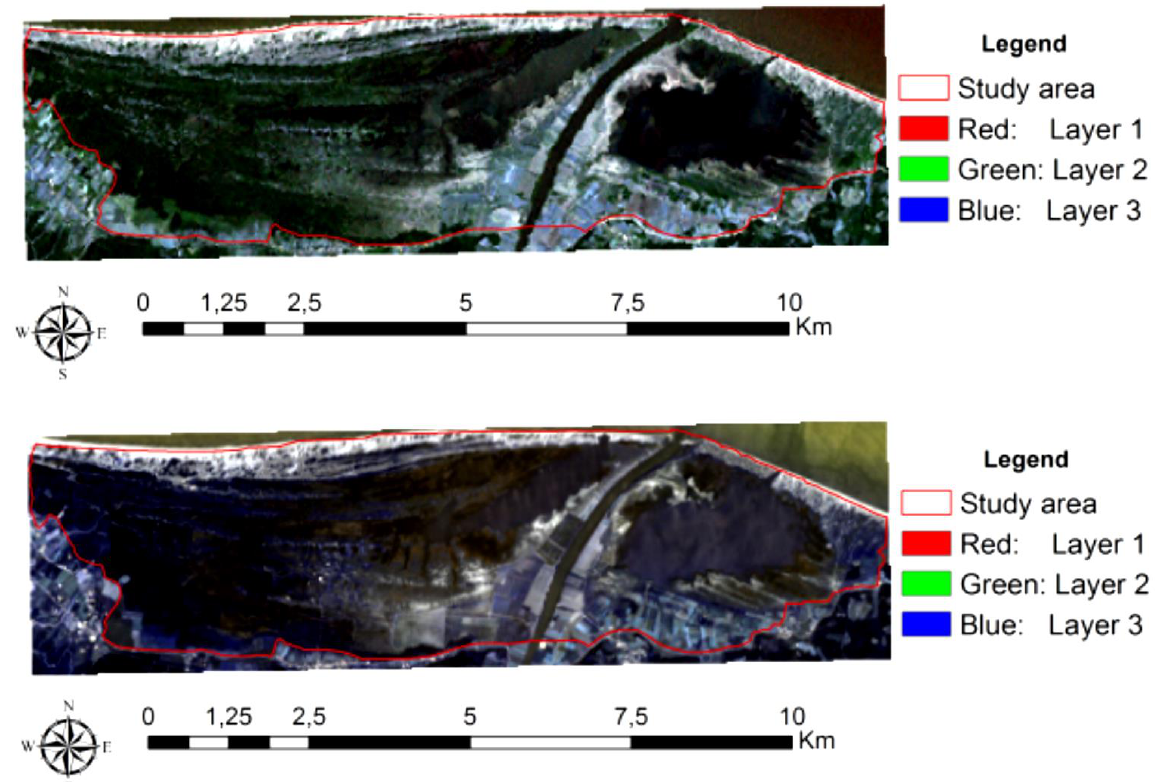
Figure 2. Study area subsets of 2000 (upper) and 2017 (lower)